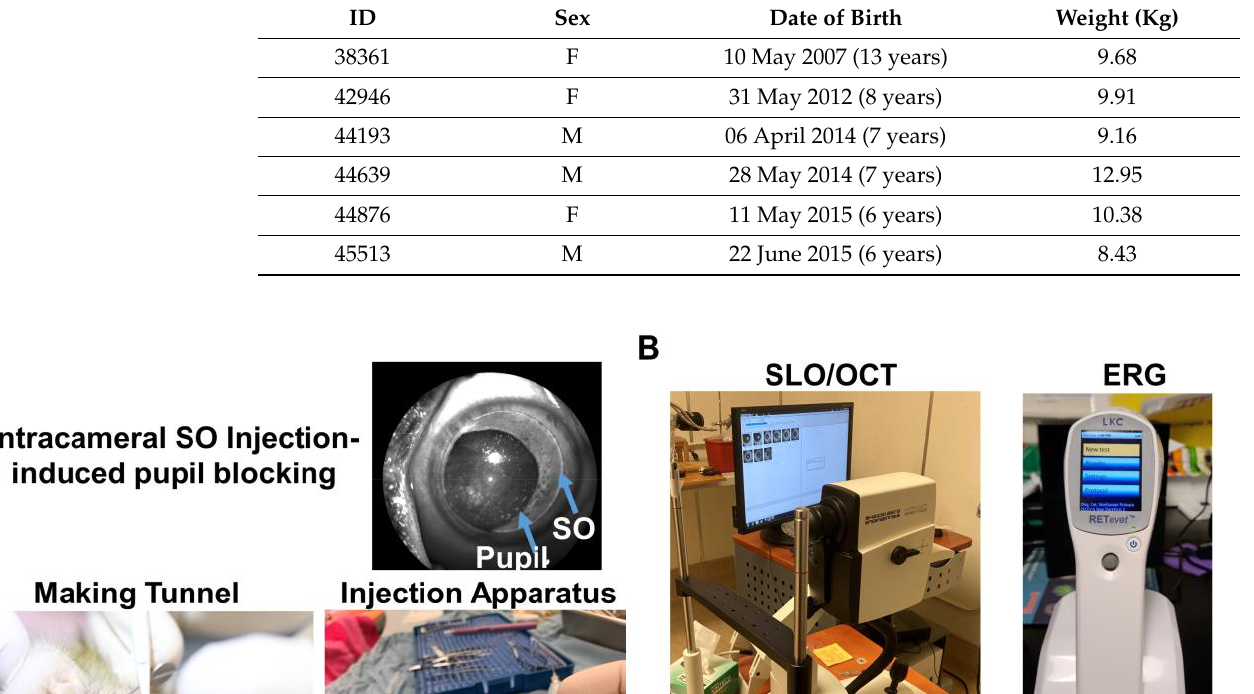
Table 1. Animal Information.